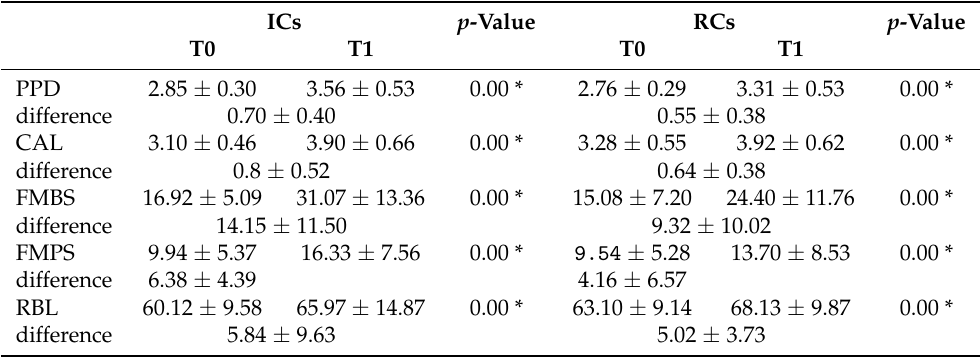
Table 6. Baseline and final examination intra-group comparisons among RCs and ICs regarding periodontal parameters.